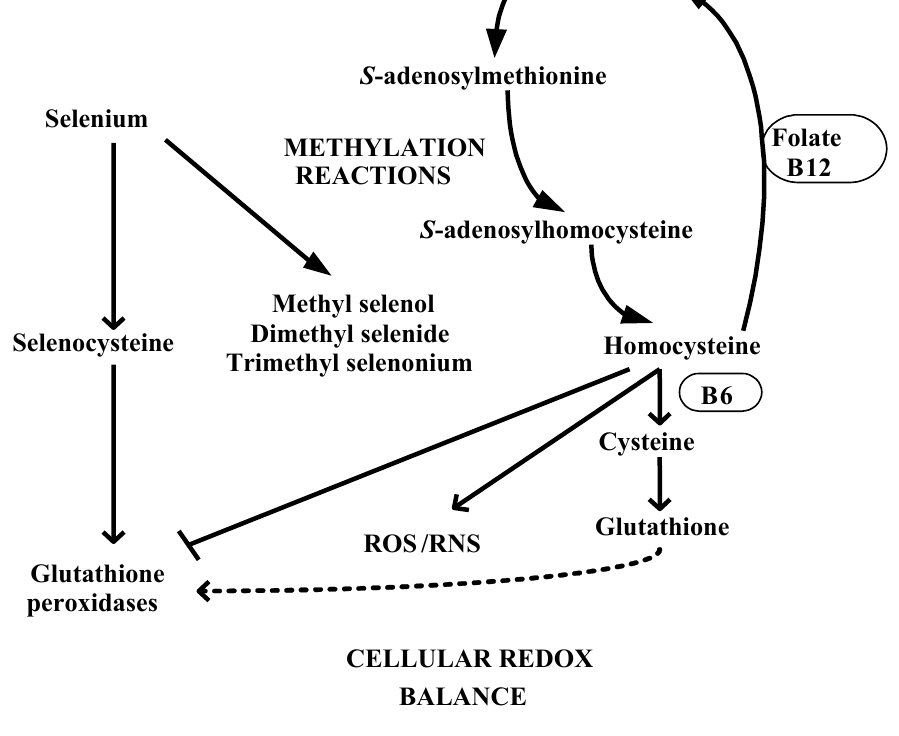
Figure 1. Interaction of selenium and the methionine-homocysteine cycle (reproduced with permission from Metes-Kosik et al. [37]). ROS: reactive oxygen species; RNS: reactive nitrogen species.